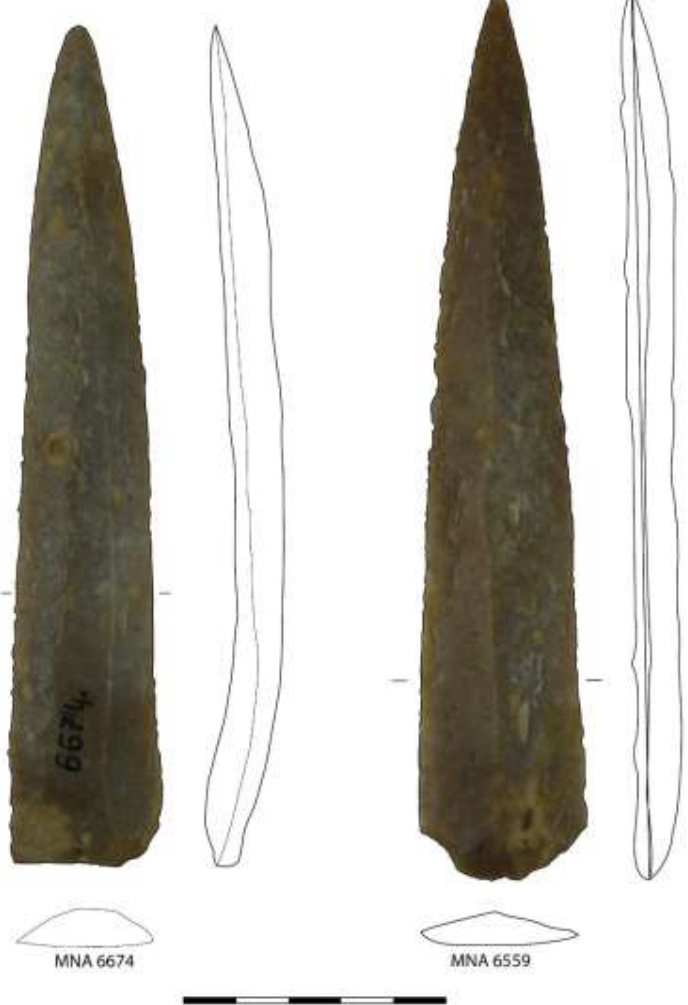
Figure 7- Two “pointed blades”: the similarity between these two items must be highlighted. The scale bar is 5 cm long (in 1 cm